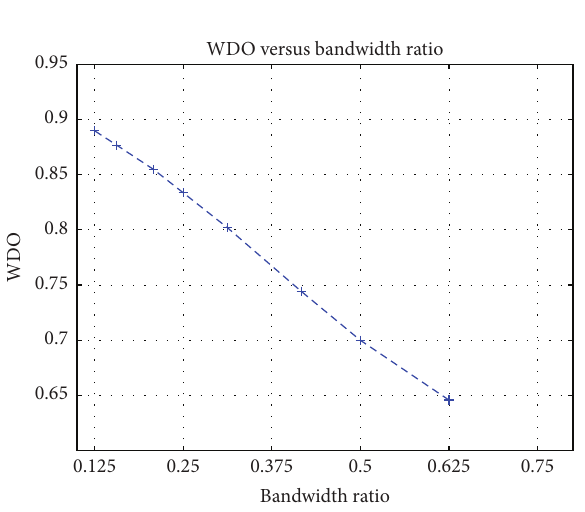
Figure 3: The SIR result.